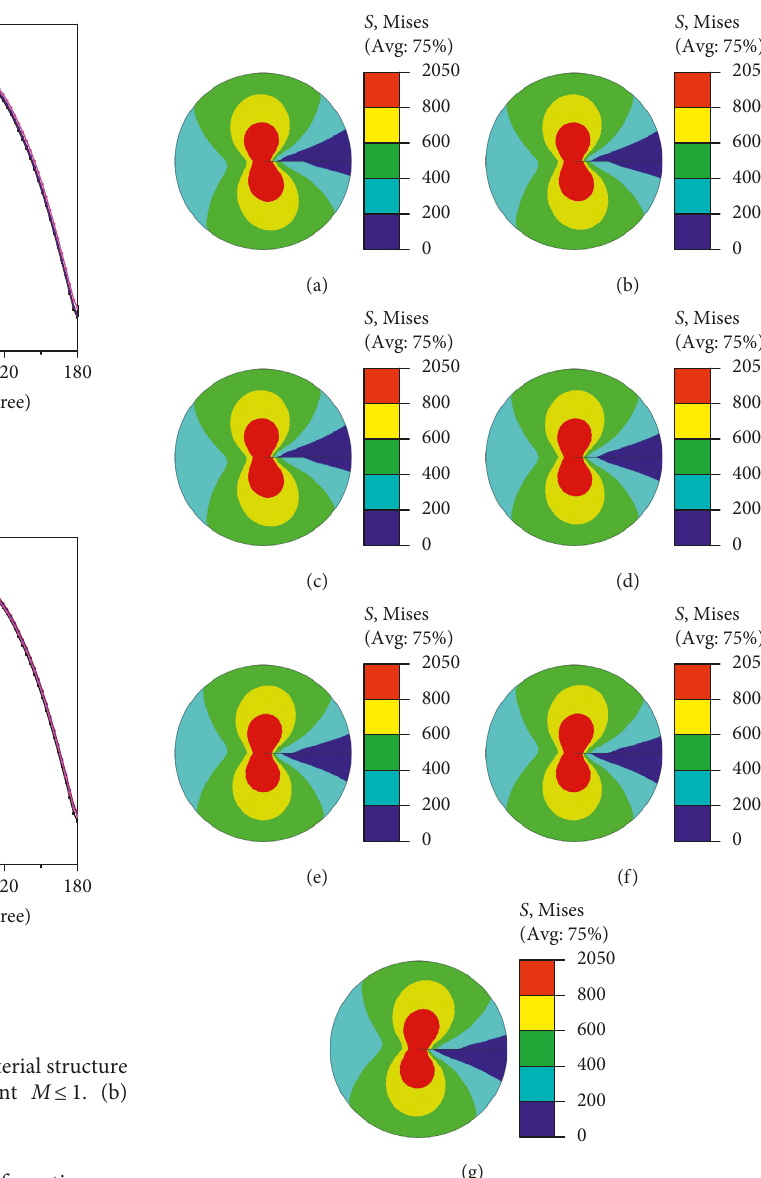
Figure 13: The Mises stress contour of continuous transition model around crack tip. (a) M � 0.7. (b) M � 0.8. (c) M � 0.9.